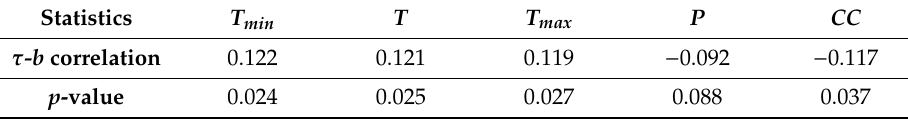
Table 3. Non-parametric correlation Kendall τ -b of Log FC y,m and p